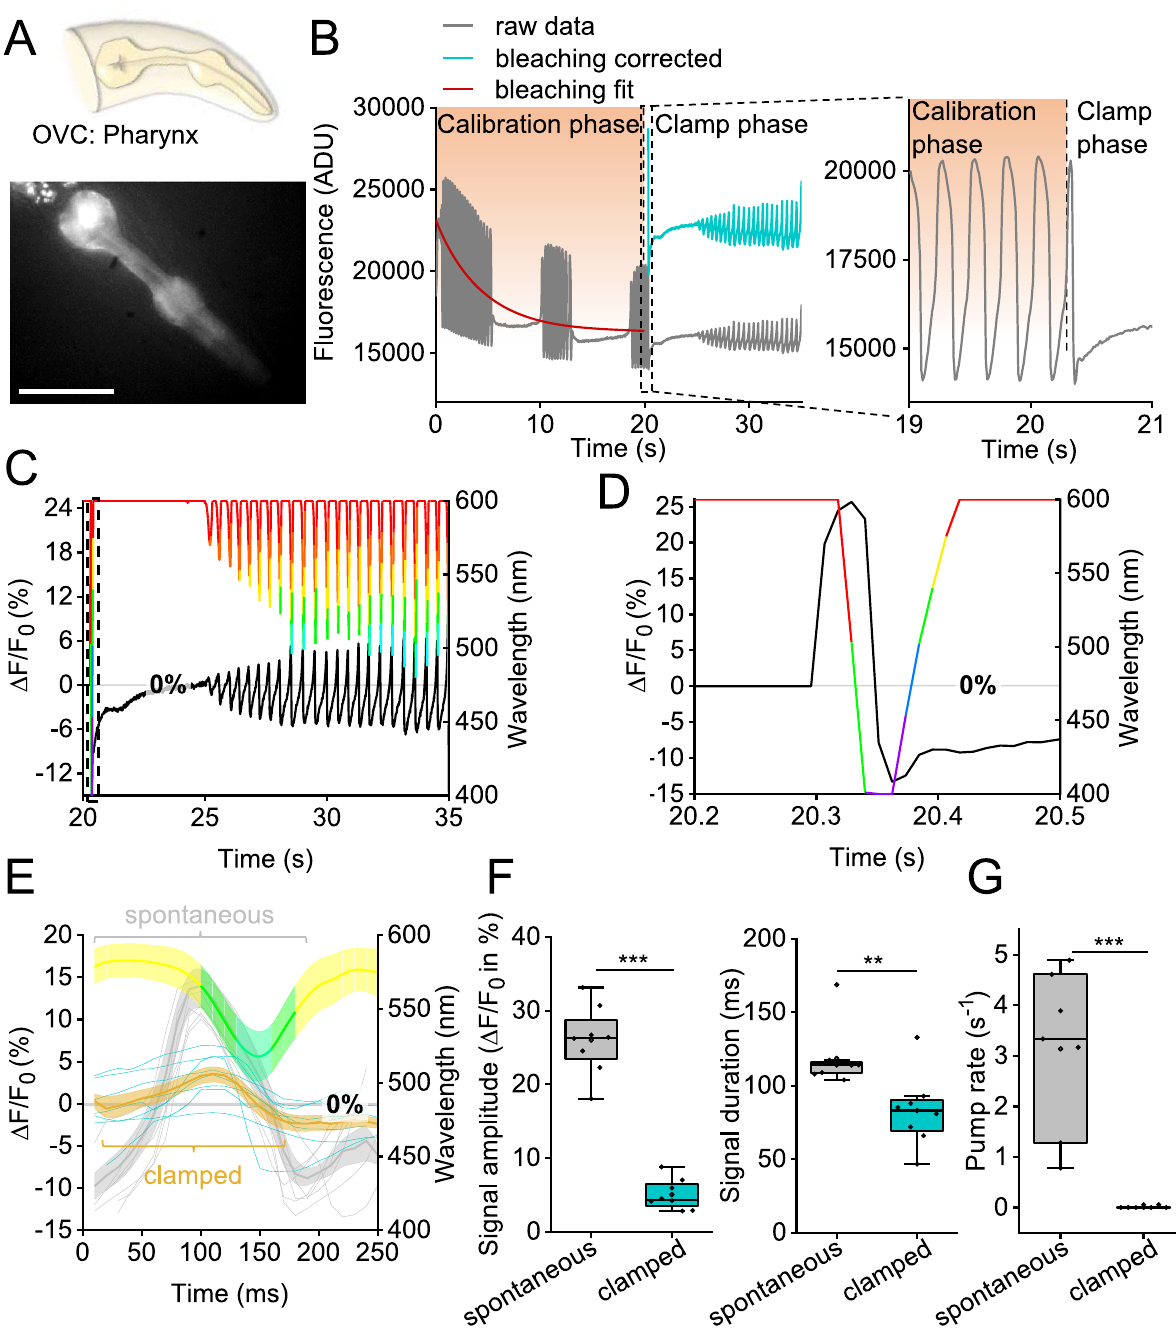
Fig. 6 | All-optical clamping of APs in pharyngeal muscle. A The pharynx, a muscular pump used for feeding, expressing BiPOLES and QuasAr2 ( fl uorescence, representative image (from n =8)). Scale bar is 50 µ m. B – D OVC experiment in pharyngeal muscle, holding fl uorescence at 0% Δ F / F 0 and suppressing APs. B Original trace, calibration and clamping. Inset: close-up of boxed region, transi- tioncalibrationtoclampphase.ADU:analog-to-digitalunits. C Overlay:wavelength and Δ F / F 0 traces during clamp phase. D Close-up of box in C : OVC counteracting fi rst AP during clamp phase. E Aligned traces of spontaneous (light gray, n =8 animals, 5 APs each) and clamped (blue) pharyngeal fl uorescence signals. Mean